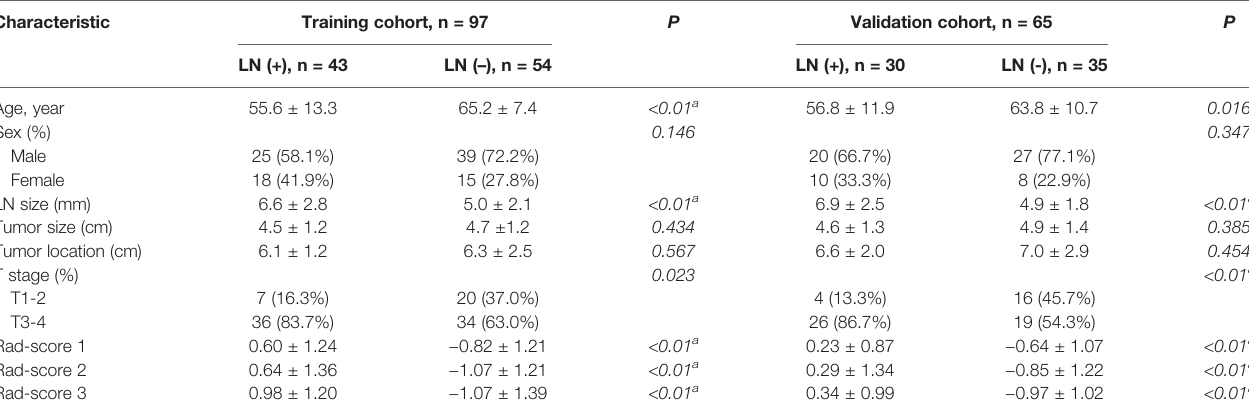
TABLE 1 | Clinical and pathological features of patients.